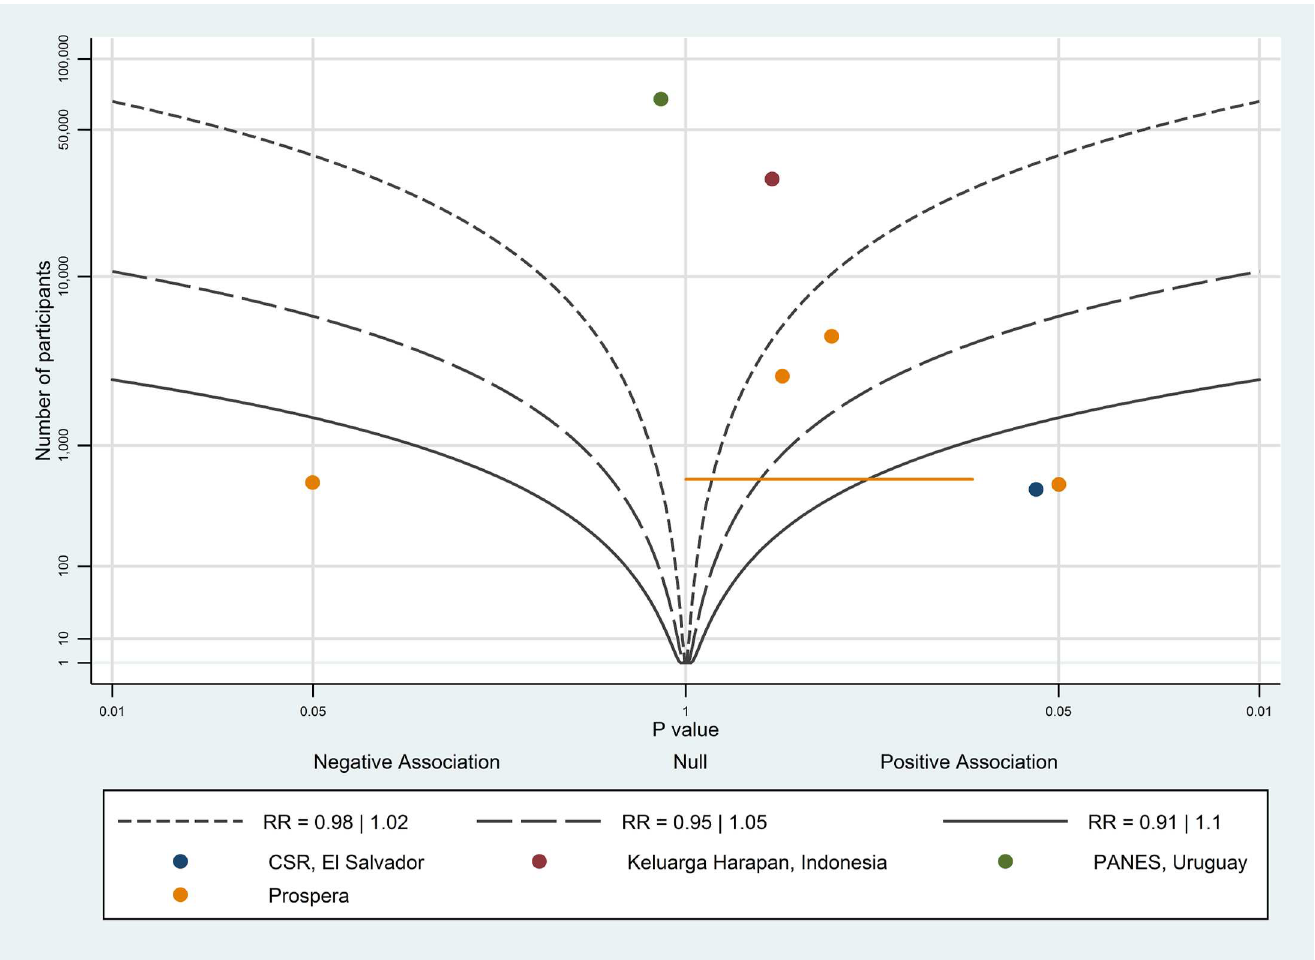
Fig 3. Albatross plot for effect of conditional cash transfer programmes on births with a skilled birth attendant. CSR—Comunidades Solidarias Rurales; PANES—Plan de Atencio´n Nacionala la Emergencia